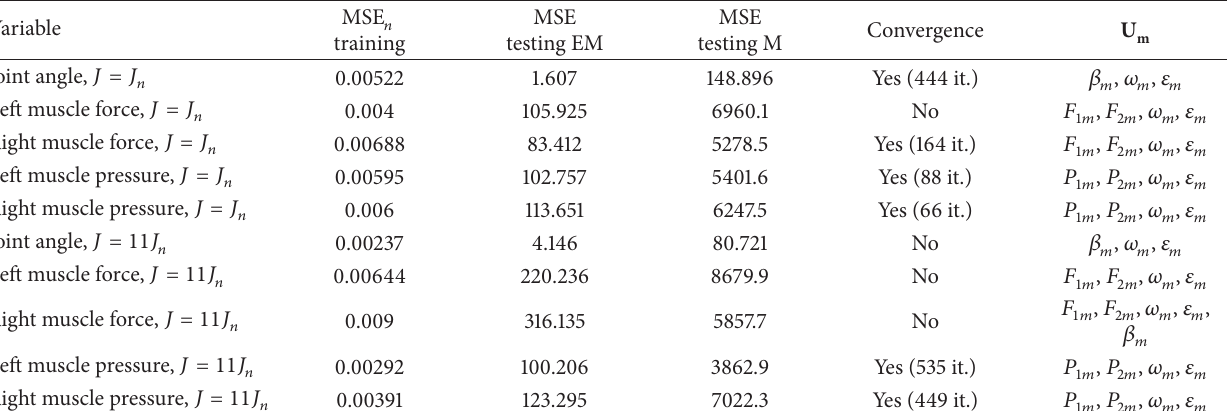
Table 4: The results of neural network training for 𝐽 = 𝐽 𝑛 and 𝐽 = 11𝐽 𝑛 . In the table, MSE 𝑛 is normalized mean squared error, MSE is mean squared error, EM is enhanced model, M is model, U m is neural network input vector, 𝛽 𝑚 is model joint angle, 𝜔 𝑚 is model angular velocity, 𝐹 𝐹 𝑃 𝜀 𝑚 is model angular acceleration, 1𝑚 is left model muscle force, 2𝑚 is right model muscle force, 1𝑚 is left model muscle pressure, and is right model muscle pressure.